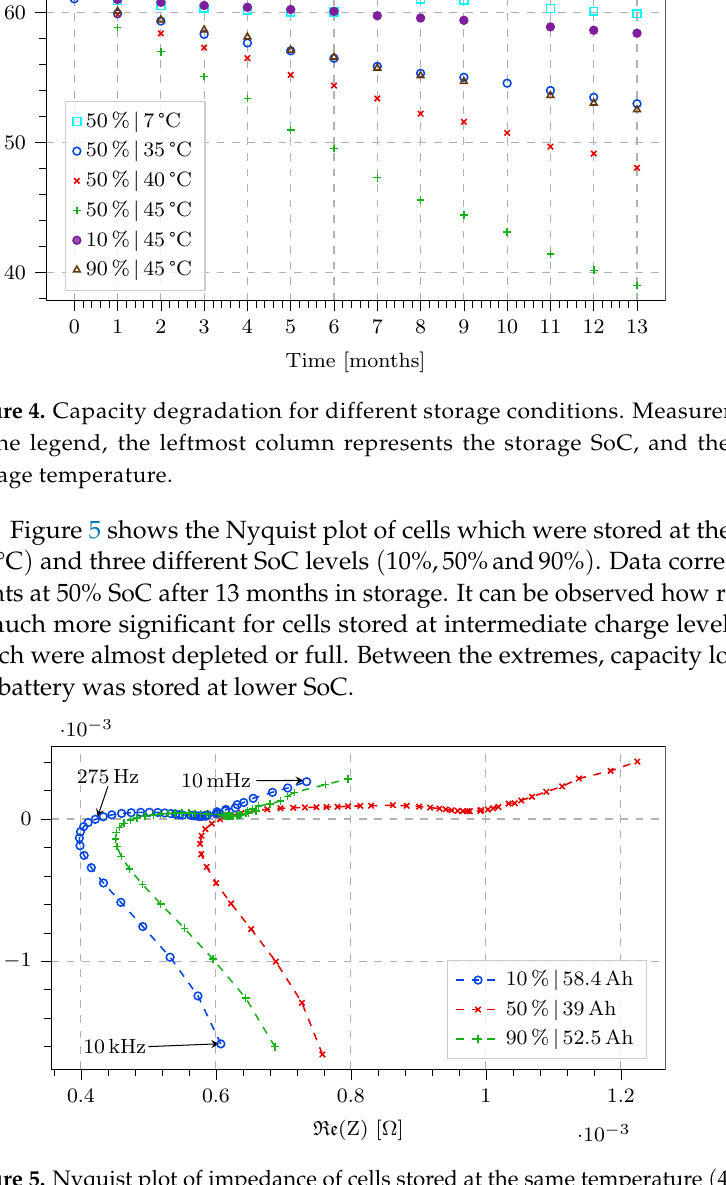
Figure 5. Nyquist plot of impedance of cells stored at the same temperature ( 45°C ) after 13 months. Measurements performed at 50% SoC and 25°C. In the legend, the leftmost column represents storage SoC, and the rightmost column shows the maximum available